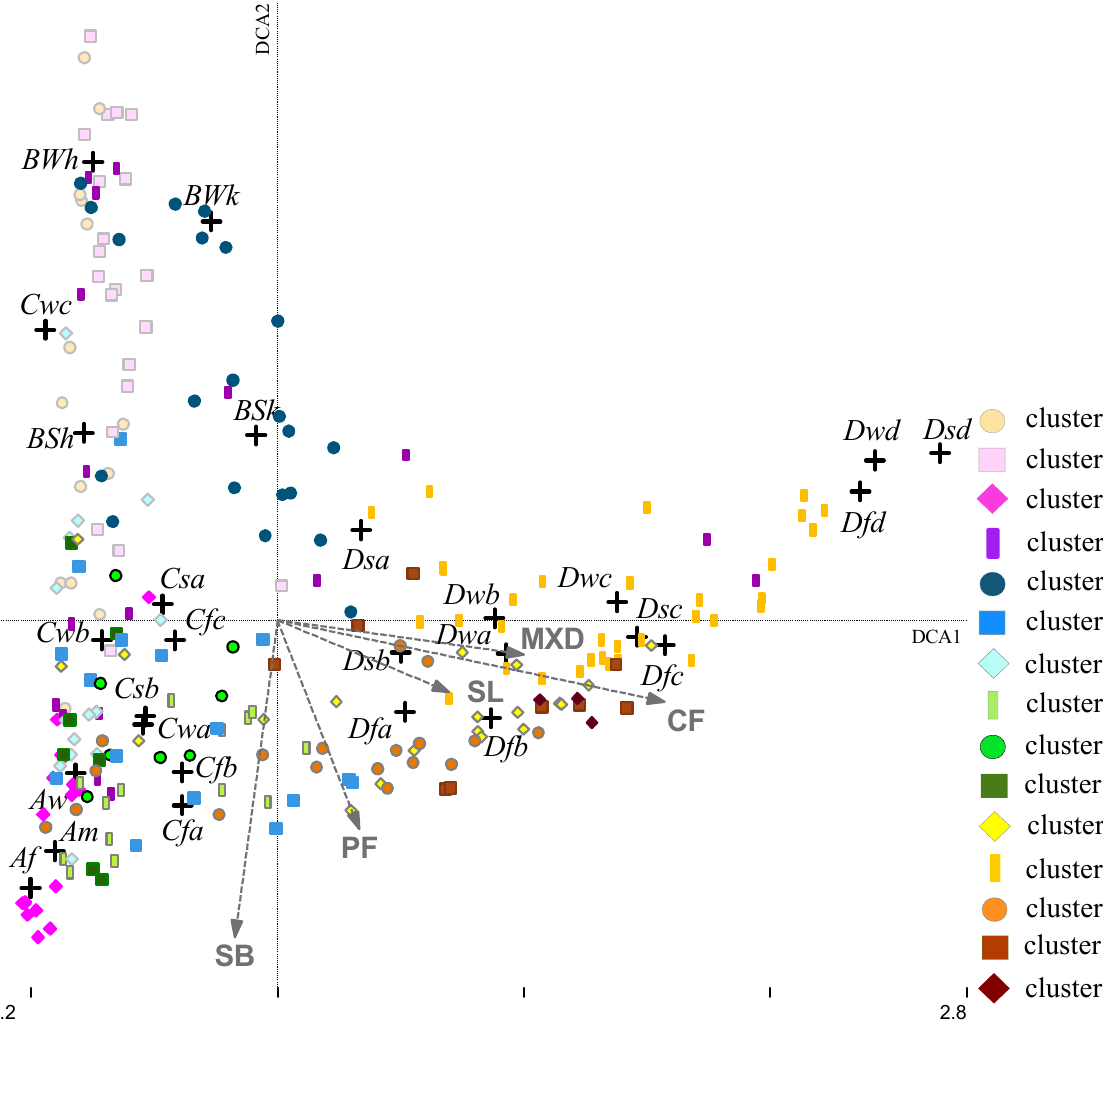
Figure 6. Detrended Correspondence Analysis (DCA) triplot of the EFTs classified in 15 clusters (icons with colors) and the Köppen climate zones (crosses). Arrows represent the phenological and productivity variables averaged within the EFTs. Their positions indicate the correlation with the DCA